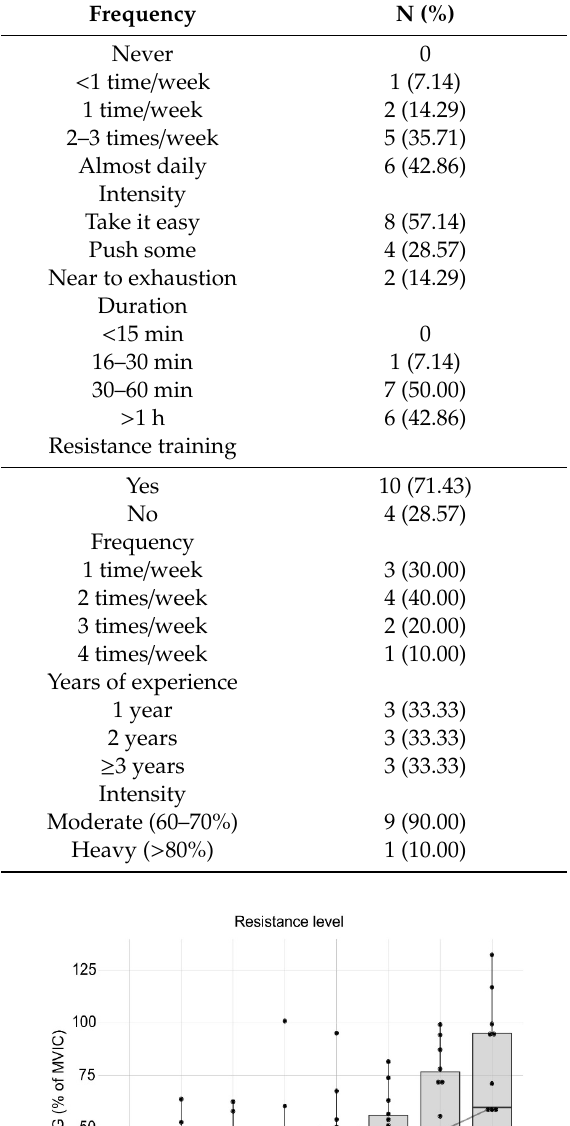
Table 2. Leisure-time physical activity.